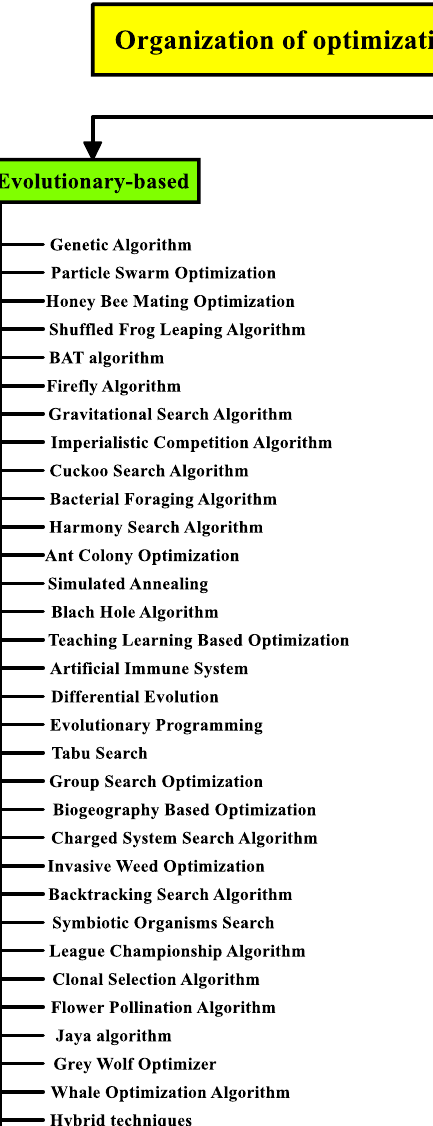
Figure 1. Classification of the optimal power flow solution methodologies.